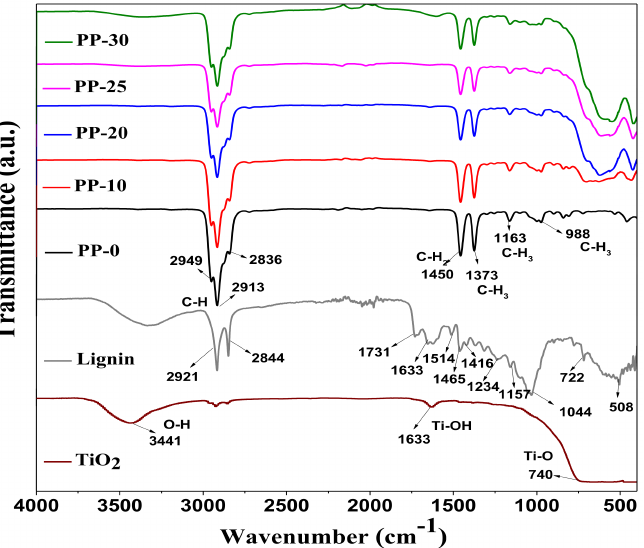
Figure 3. FTIR spectra of composites of PP–TiO 2 /lignin (PP-10, PP-20, PP-25, and PP-30), polypropy- lene (PP.0), lignin, and TiO 2